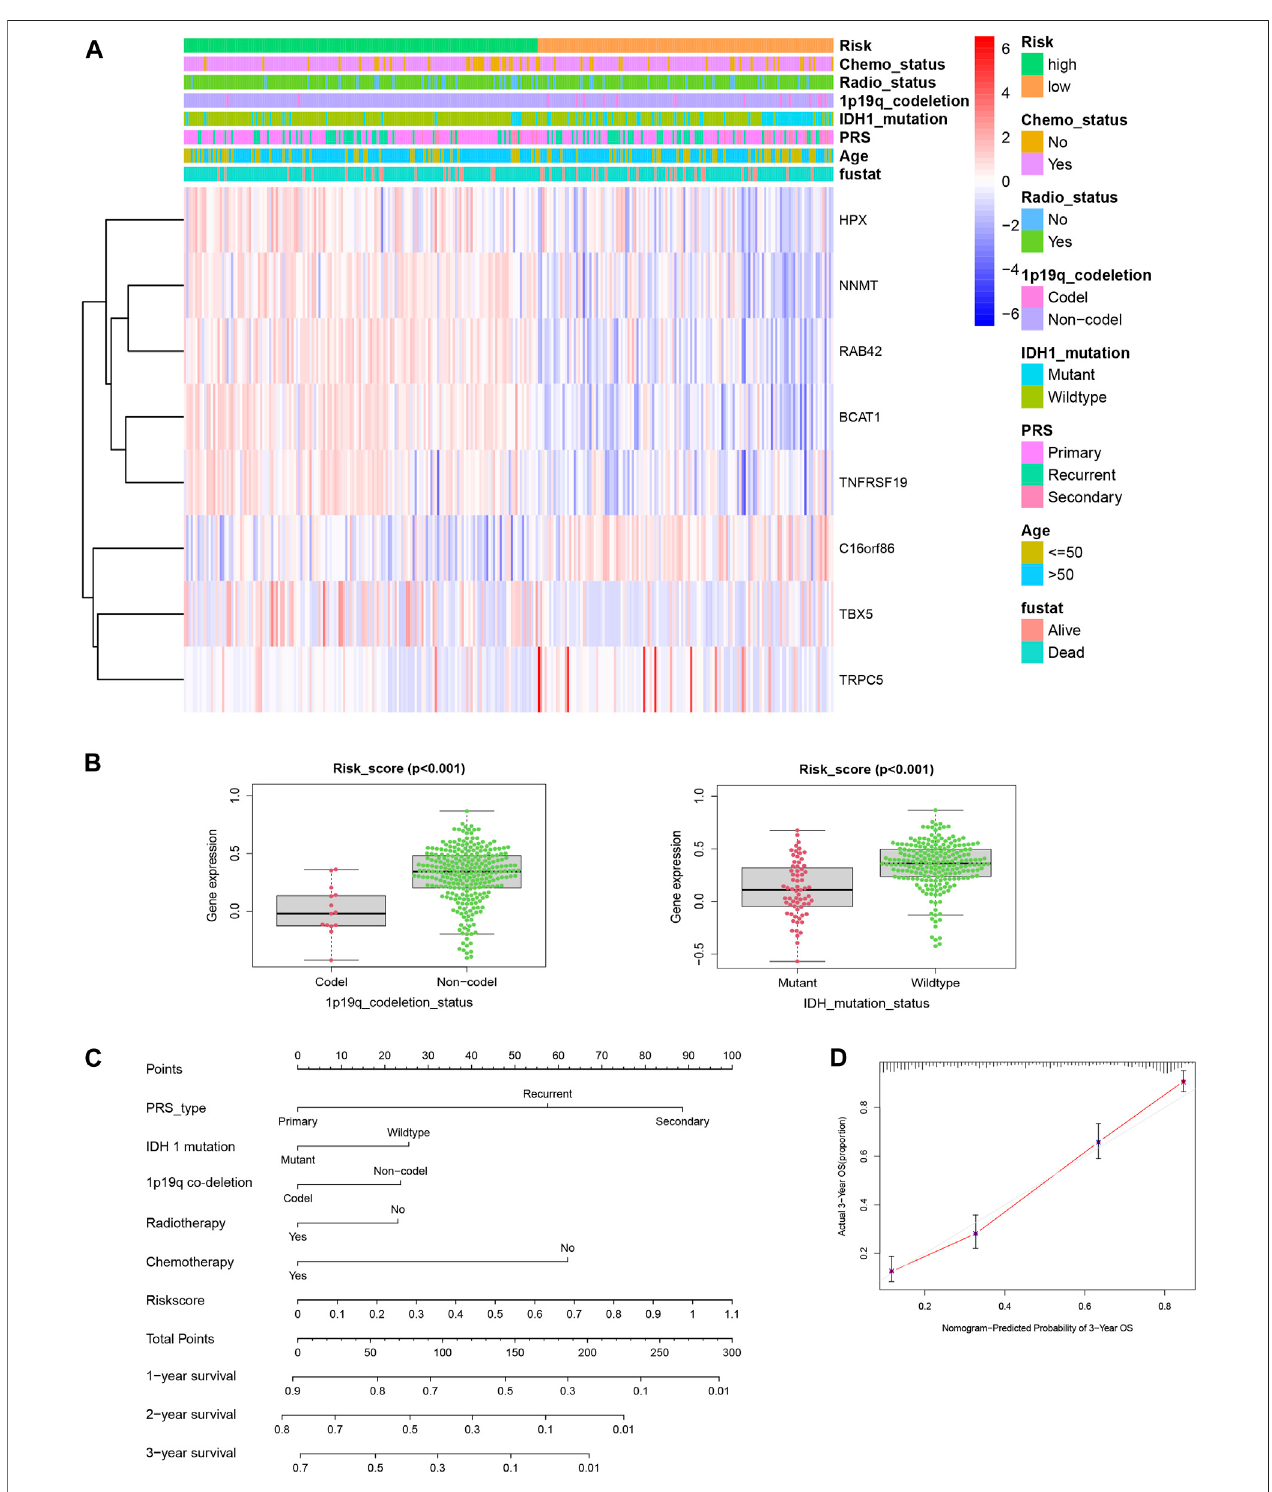
FIGURE 5 | (A) Distribution of the risk score, the clinical parameters and the signature mRNA expression heat map in the TCGA dataset. (B) Risk score of GBM patients was signi fi cantly related to 1p19q co-deletion status (Codel, n = 15; Non-codel, n = 275, p < 0.001) and IDH1 mutation status (mutation, n = 67; wildtype, n = 223, p < 0.001). (C) Nomogram showed theprediction ofsurvivalpossibilitiesforGBM patients in1,2, and3 years. (D) Nomogram-predictedprobabilityof3-yearOSin GBM patients.